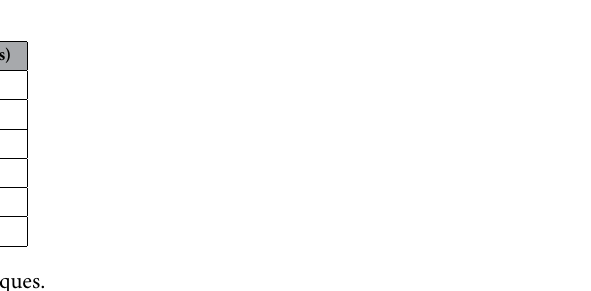
Table 3. CPU time for two different